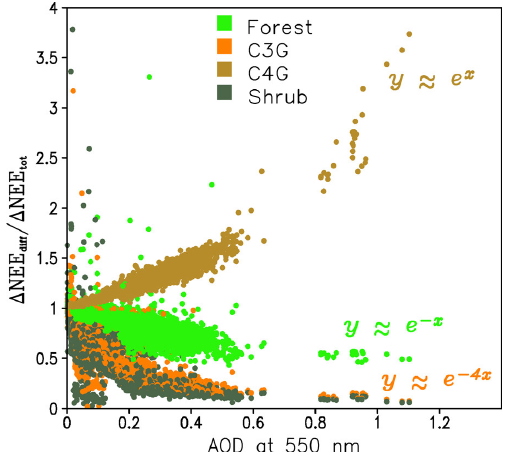
Figure 18. The contribution of the diffuse radiation effect to NEE ( (cid:49) NEE diff /(cid:49) NEE tot ) as a function of AOD in the LBAR, but sep- arated with different colors for different types of vegetation. The model data were filtered for cloudiness and precipitation. Addition- ally, only model points with the same soil water factor for all three experiments and a soil moisture difference below 0.001m 3 m − 3 were included. The fitting functions of the (cid:49) NEE diff /(cid:49) NEE tot ver- sus AOD for each biome are also shown in the